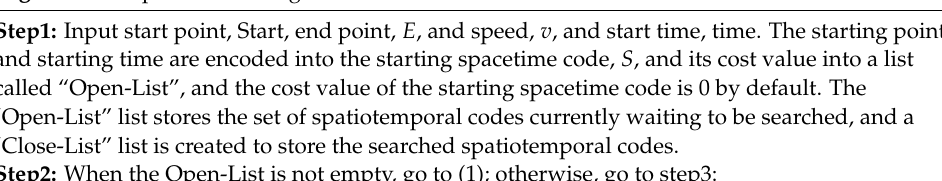
Algorithm 6: Spacetime-A*